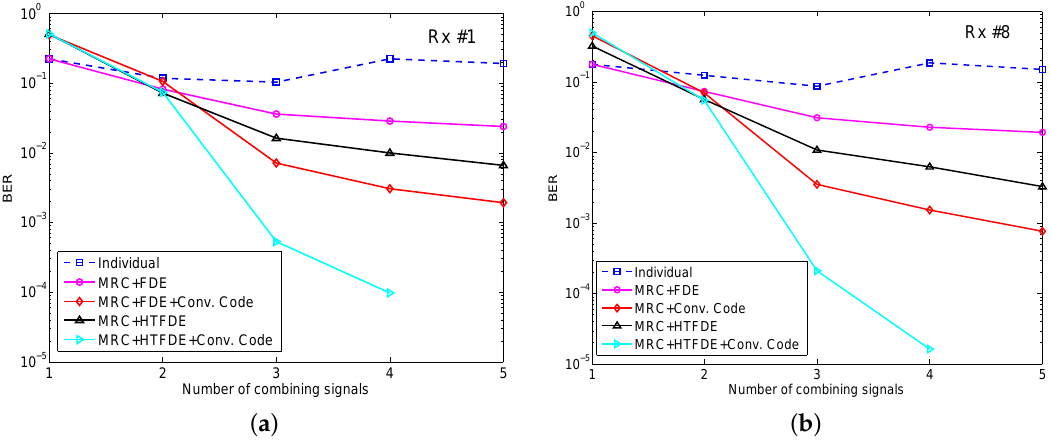
Figure 7. Performance comparison between ( a ) top (Rx #1) and ( b ) bottom (Rx #8). Three different approaches are compared: (1) individual performance without combining; (2) MRC with FDE; (3) MRC with convolution code; (4) MRC with HTFDE; and (5) MRC with HTFDE and convolution